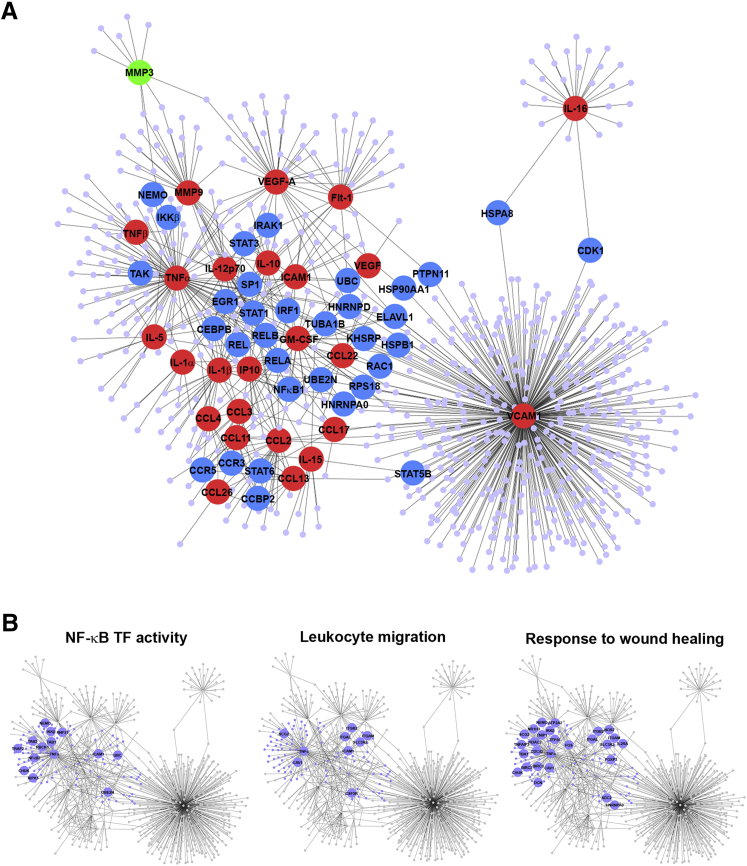
Network and module analysis. A: Protein-protein interaction network built from differentially expressed markers. Red indicates up-regulated marker protein; green, down-regulated marker protein; blue, proteins with either degree (number of interactions) ≥5, betweenness centrality ≥0.01, or one of a selected set of proteins of interest [transforming growth factor β–activated kinase, IL-1 receptor associated kinase (IRAK) 1, STAT3, Iκ B kinase (IKK) β, or NF-kappa-B essential modulator]. B: Network with one module (highly connected subnetwork) highlighted in purple. Large labeled nodes show proteins associated with selected enriched gene ontology biological processes mapped to the module; highlighted nodes are associated with the processes positive regulation of NF-κB transcription factor activity, leukocyte migration, and response to wound healing. CCBP, chemokine-binding protein 2; CEBPB, CCAAT/enhancer binding protein beta; EGR, early growth response protein 1; GM-CSF, granulocyte-macrophage colony-stimulating factor; HSP, heat shock protein; MMP, matrix metalloproteinase; TNF, tumor necrosis factor; VEGF, vascular endothelial growth factor.